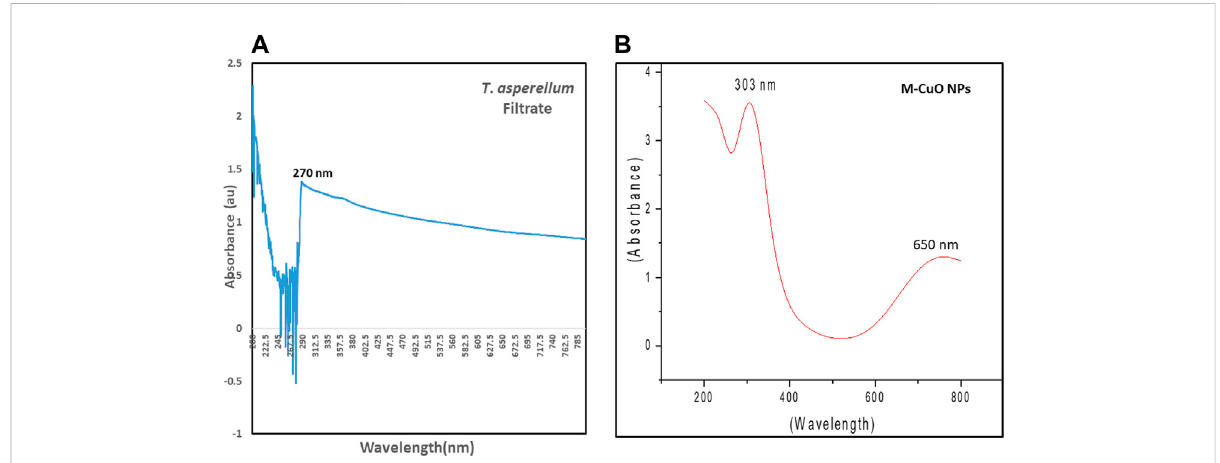
FIGURE 2 UV – visible spectra of (A) T . asperellum fi ltrate and (B) M - CuO NPs.